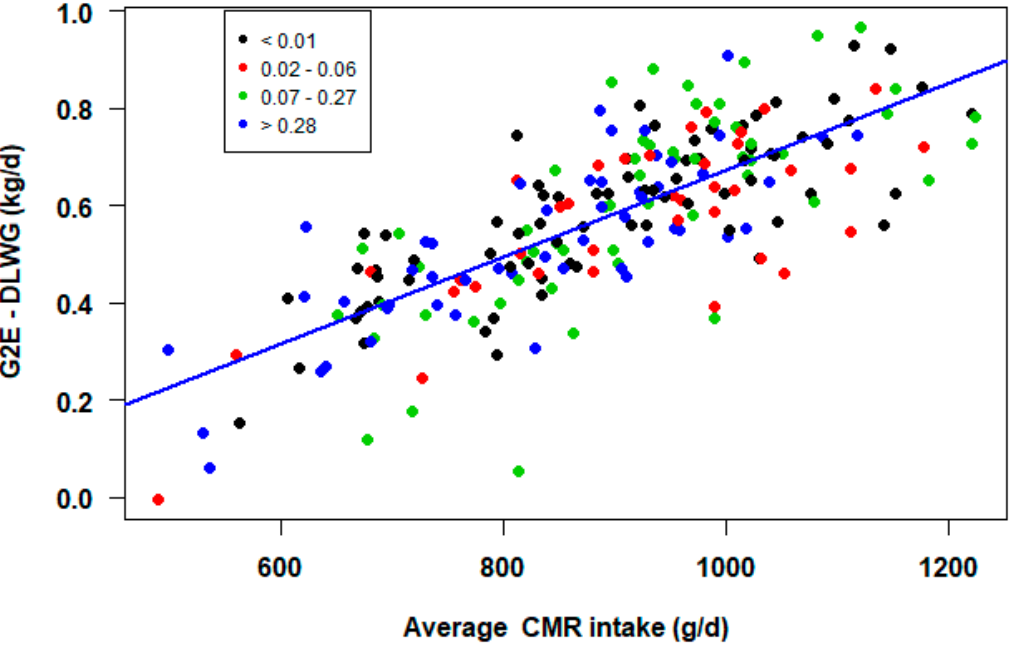
Figure 4. Effect of average CMR intake (g/d) on daily liveweight gain (DLWG, kg/d) between entering the group housing igloo pen and the end of the study period (G2E) by proportion of hours below LCT (<0.01, 0.02–0.06, 0.07–0.27, >0.28).